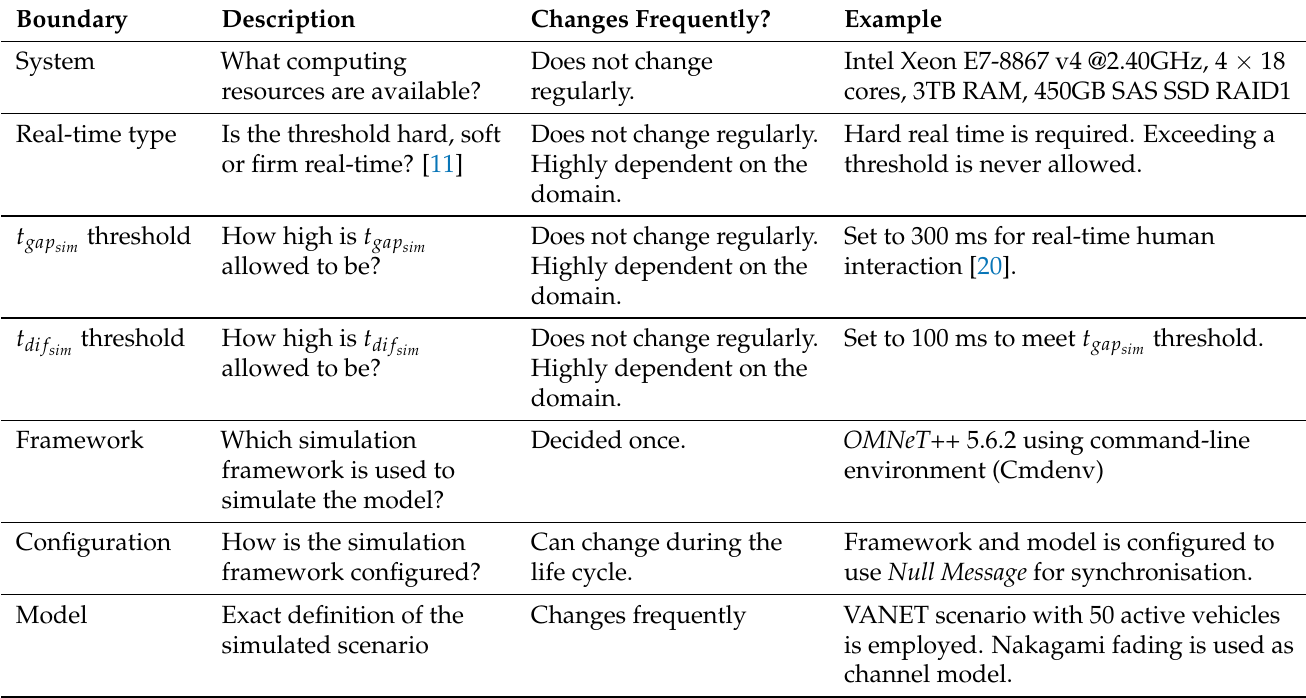
Table 2. Minimum set of boundary conditions to make the metric